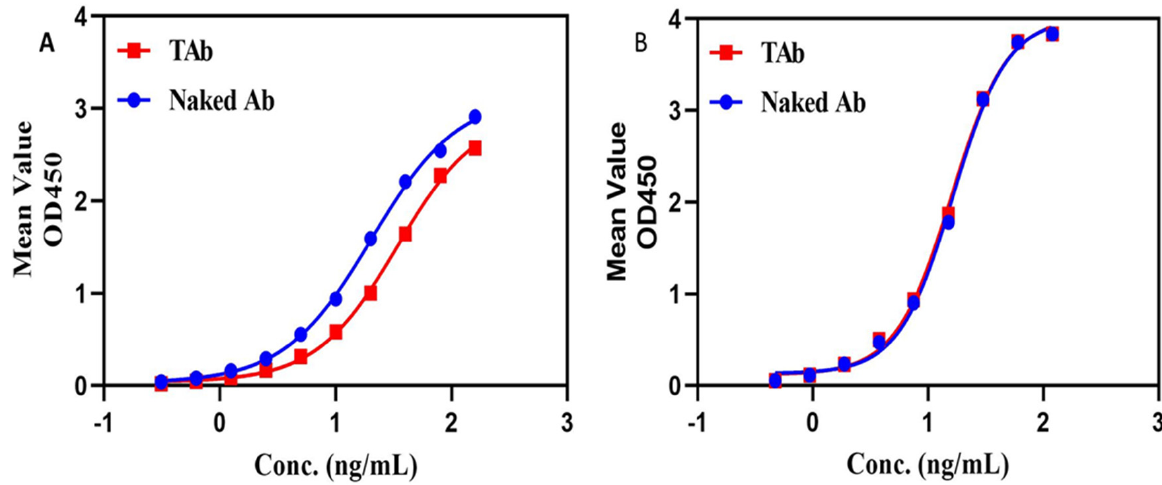
Figure 5. DAR effect on TAb assays. One TAb assay was configured with target antigen for capture and an HRP-labeled polyclonal antibody for detection, but the assay gave higher binding signals for the drug unconjugated antibody than for the TAb (see ( A )). Another TAb assay was configured with the same target antigen for capture but with a HRP-labeled monoclonal anti-Fc antibody for detection, and the assay gave almost the same binding signals for the drug unconjugated antibody and for the TAb (see ( B )). The blue line represents the drug unconjugated antibody, namely naked antibody, and the red line represents the TAb.